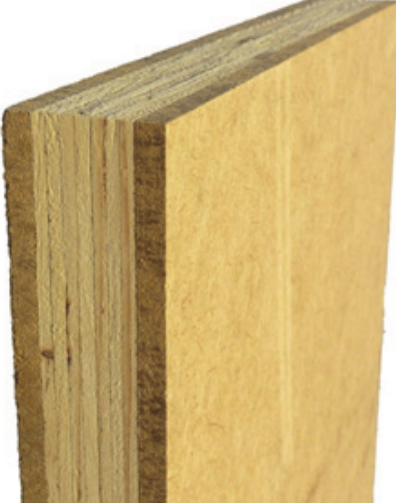
Figure 2: PlyBoard is a three-layered composite wood panel with a core of LVL and surface layers of hard fibreboard [3]. The panel is available in thicknesses between 19 and 42mm. The standard format is 1200 × 2400